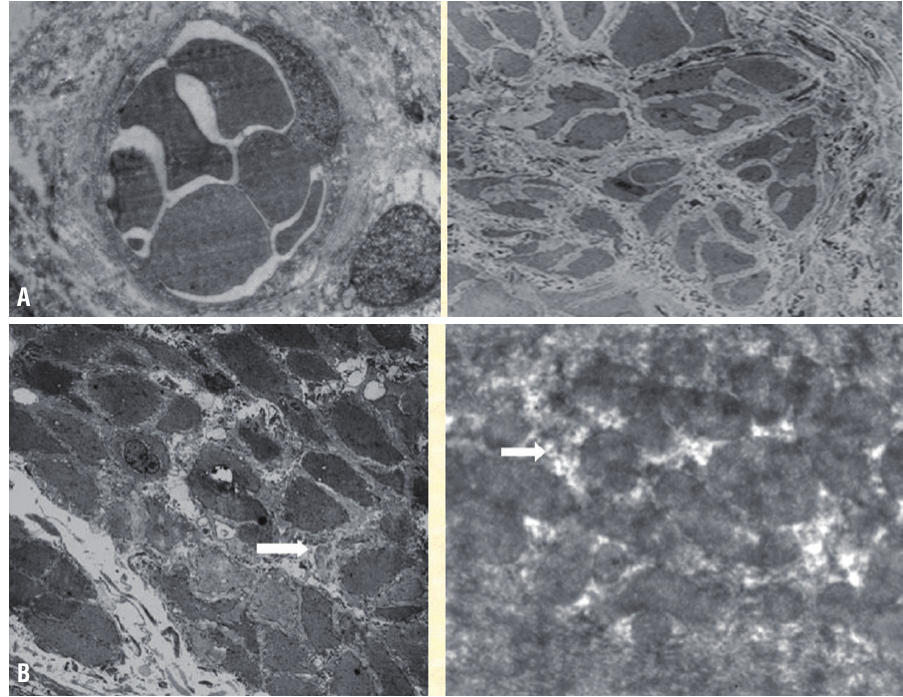
Figure 2 - a) Myohypertrophy (a-X-27600 and b-X-13000). Marked intercellular separation and cellular hypertrophy. Excessive collagen present between the cells as well as between the fascicles. Red arrow shows myohypertrophy and black arrow shows excessive collagen and 2b) shows myohypertrophy in obstructed bladder shown by red arrow and loose fascicle with increased intercellular space shown by black arrow